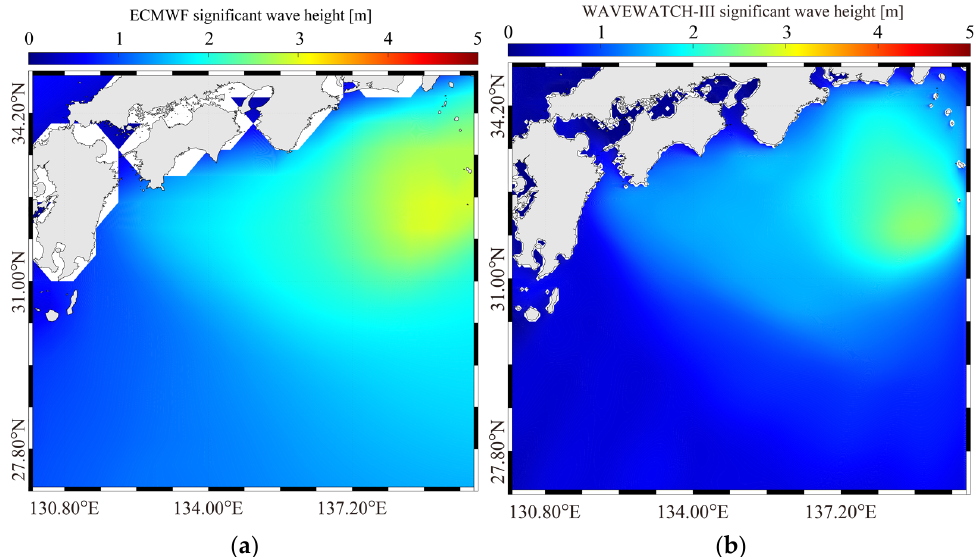
Figure 4. The significant wave height (SWH) maps at 09:00 UTC on 20 Sep 2021 from the ( a ) ERA-5 and ( b ) WAVEWATCH-III (WW3) data.